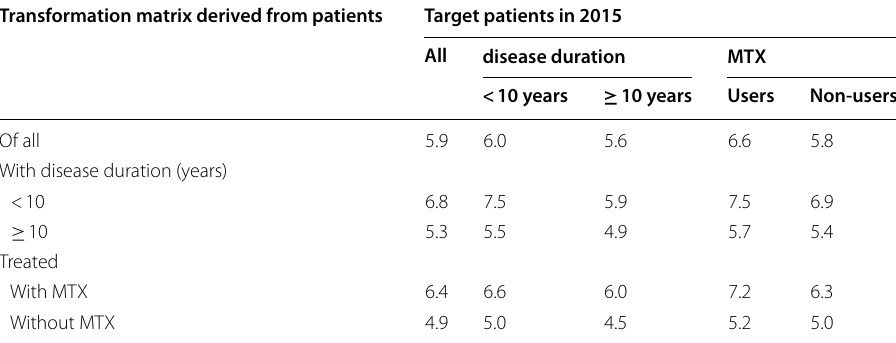
The large-joint-dominant patients of 2016 were predicted with estimated vectors from various target patients in 2015 using different transformation matrices derived from the joint index vectors of patient data serially registered in 2013 and 2014 MTX methotrexate